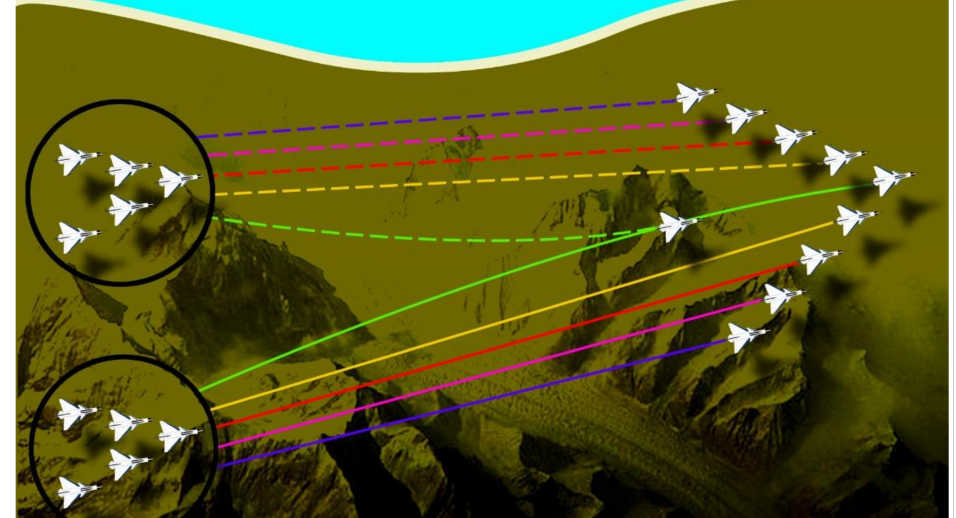
Figure 2. Scenario 2 containing 10 UAVs divided into two clusters in leader-follower formation on the left, the two clusters merge into one swarm on the right.